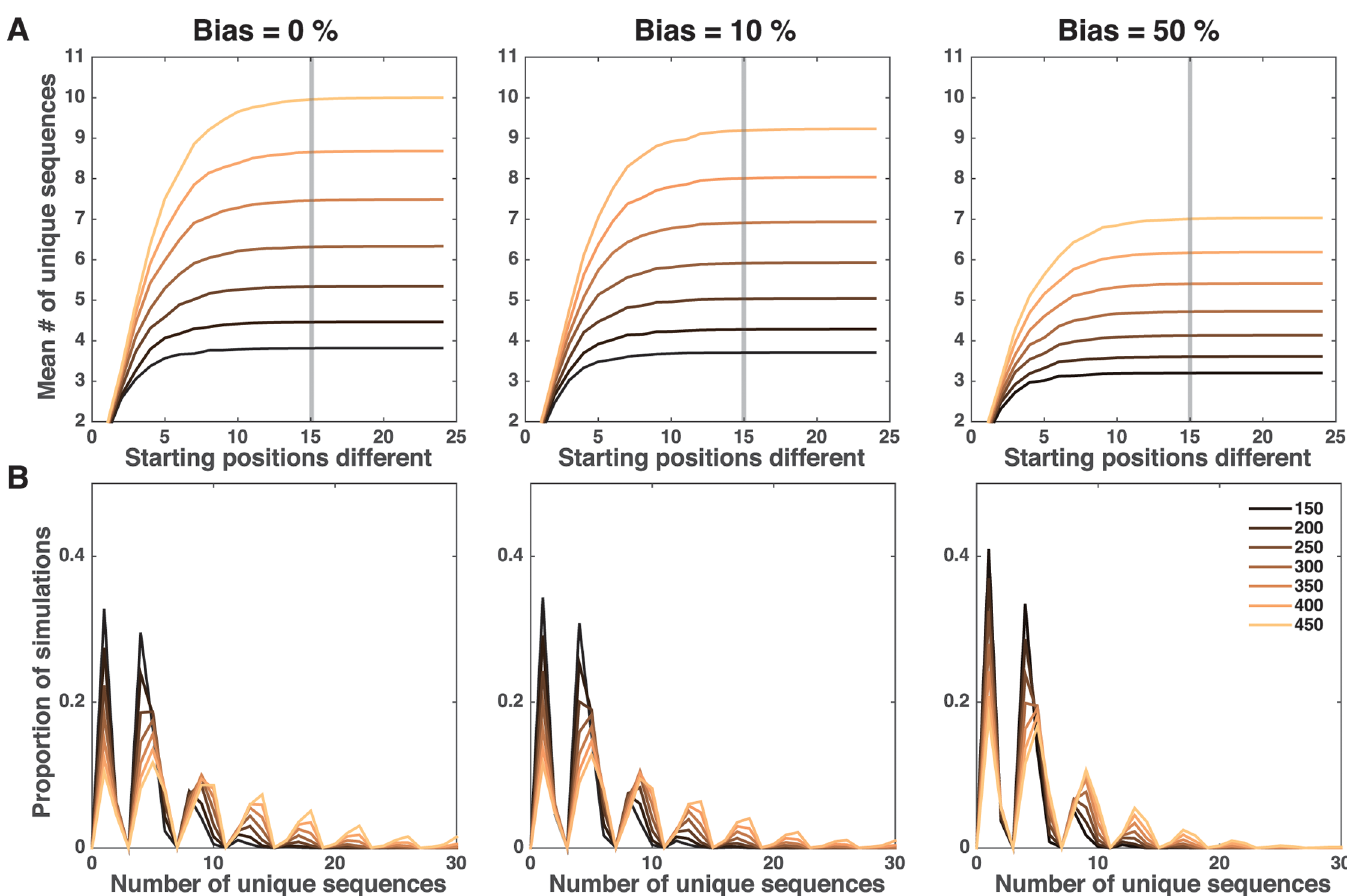
Fig 6. Number of unique barcode sequences. (A) The numberof uniquebarcodesequencesfrom two geneticallydistinct parasite populationsas a function of the numberof barcodepositionsthat initiallydiffer. (B) Distributionof the uniquebarcodesequenceswhen lookingat 15 differencesbetweenthe two initial parasite populations. Colors indicate the numberof starting gametocytes with darker colors representinglower initial gametocyte numbers. Left to right the columns illustrate the results for 0%, 10% and 50% fitness biases, respectively. Gray bars in (A) show the similarity in parasite populationsfor the distributions in